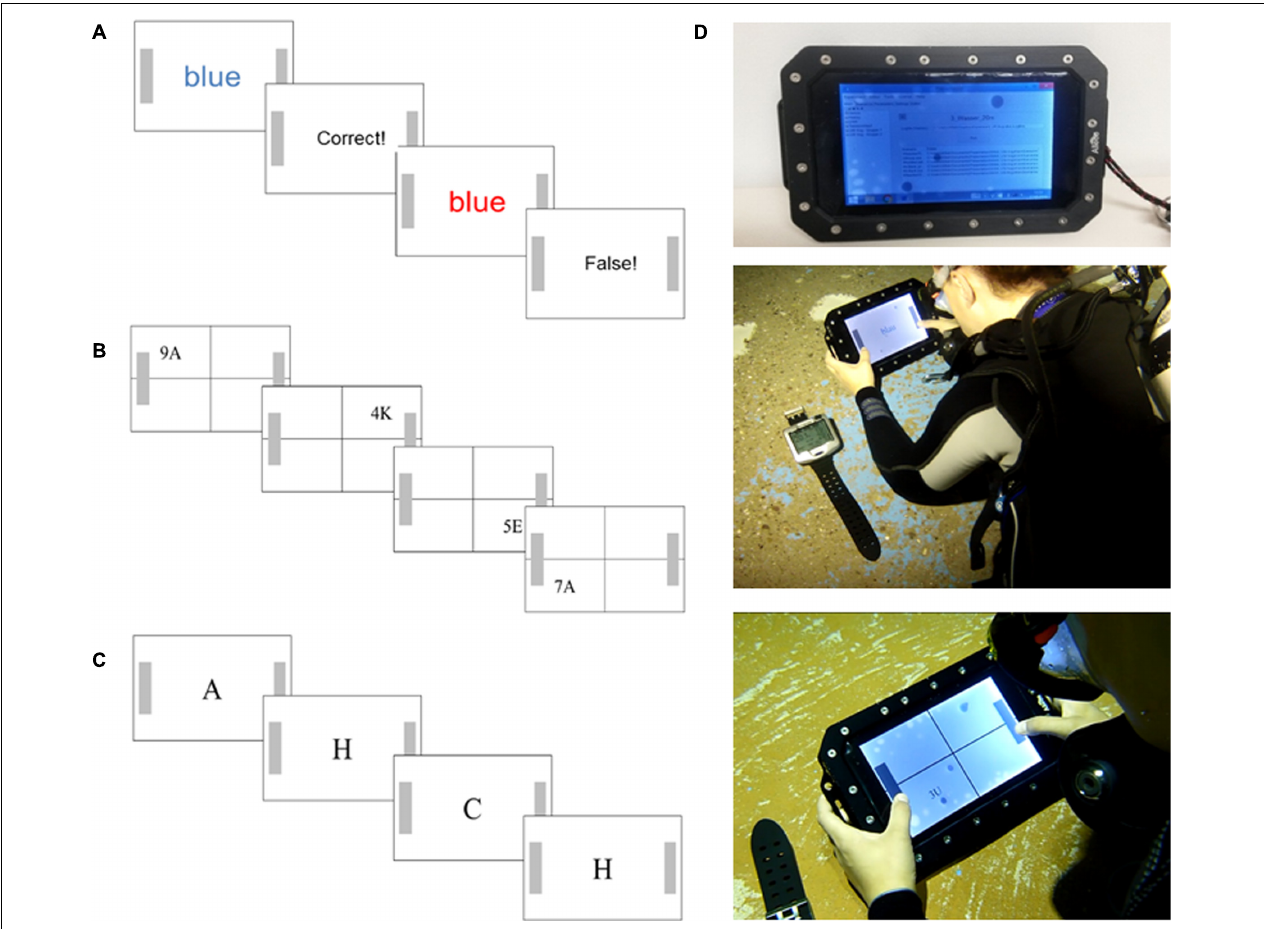
FIGURE 1 | Test sequence and test setup: Example stimuli sequence of (A) the Stroop test, (B) the Number/Letter Test, and (C) the 2-back test. (D) Photography of the underwater tablet computer, the diving computer, and a diver performing the tests underwater. More details are presented within the